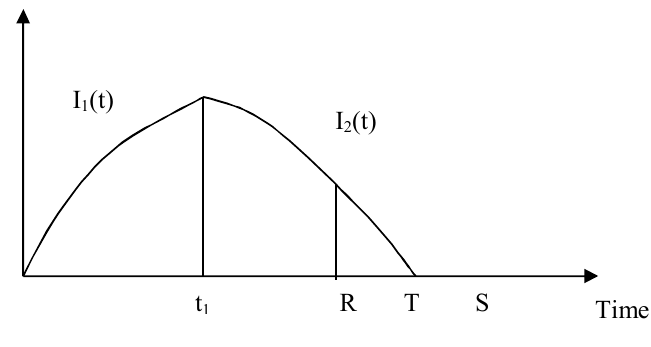
Fig. 2. Inventory versus time (Case-2: R ≤ T ≤ S )